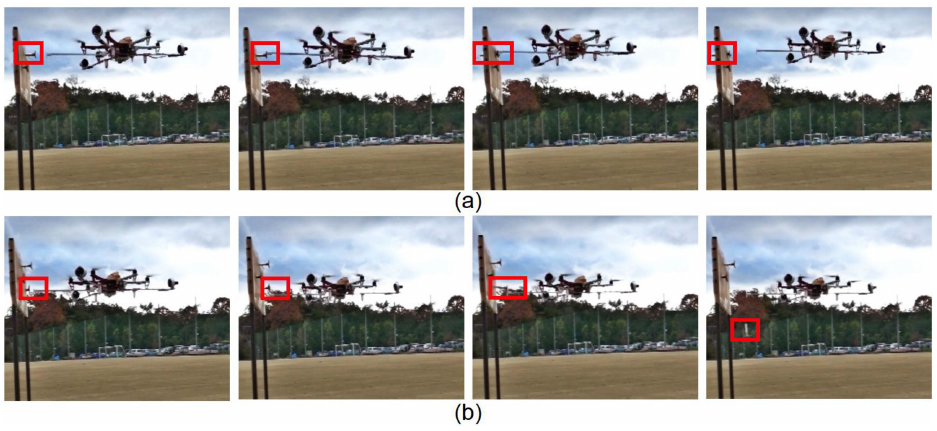
Figure 12. Continuous images of push ( a ) and pull ( b ) tasks. The images follow from left to right and the red region shows the target object. The video of the experiment is available from the supplementary materials.